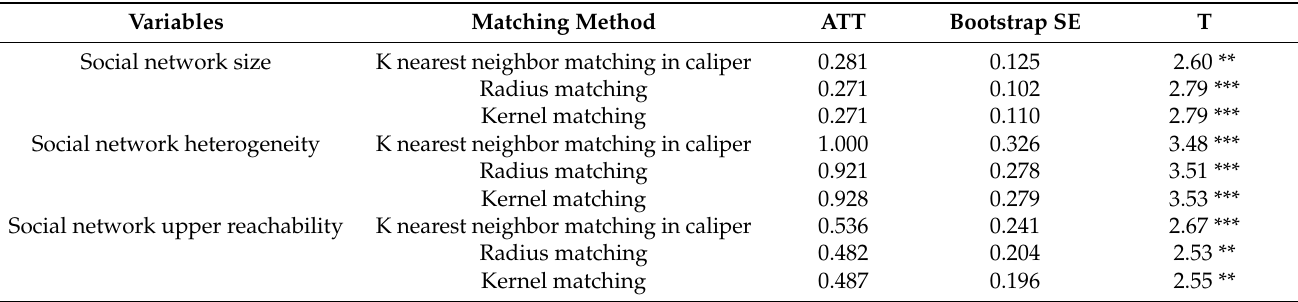
Table 4. ATT values of Internet use on the social networks of the elderly.